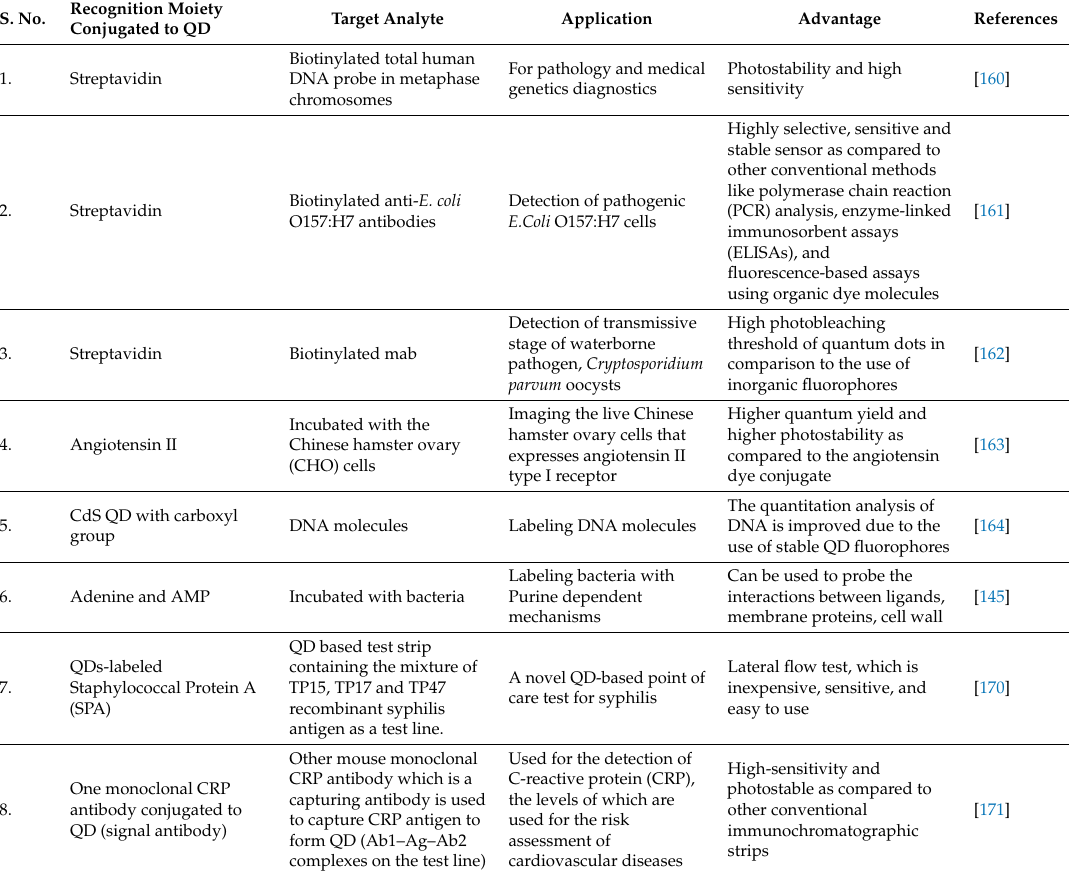
Table 1. Various applications and advantages of biofunctionalized quantum